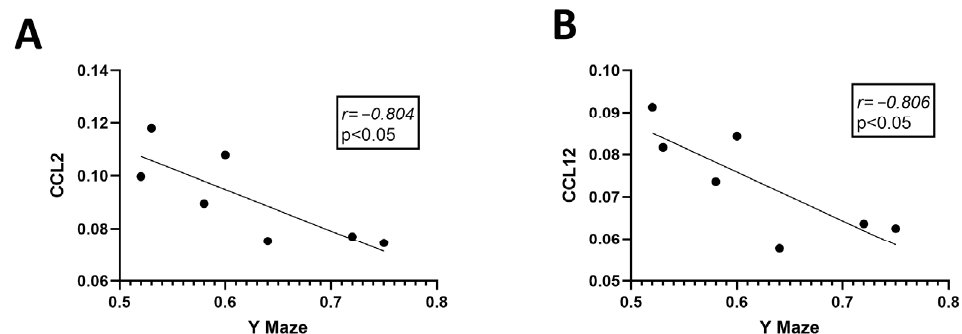
Figure 6. Cognitive behavior correlates with chemokine serum levels in aged mice. Linear regres- sion graphs depicting the correlation between CCL2 and CCL12 serum levels and behavioral per- formance in the Y-maze test ( A , B ), respectively (N = 7). Correlations were calculated using Pearson